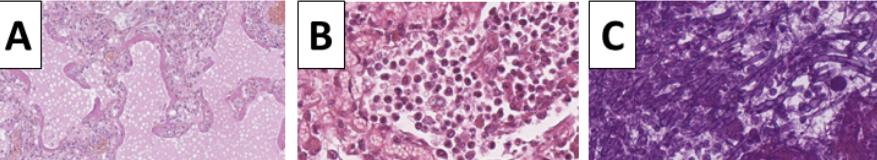
Figure 5. Non-specific pulmonary changes associated with SARS-CoV-2 infection, Hyaline mem- branes, and edema in COVID-19: ( A ) pulmonary hyaline membranes and vacuolated intra-alveolar edema; ( B ) secondary bacterial infection (purulent bronchopneumonia); ( C ) secondary fungal infec-